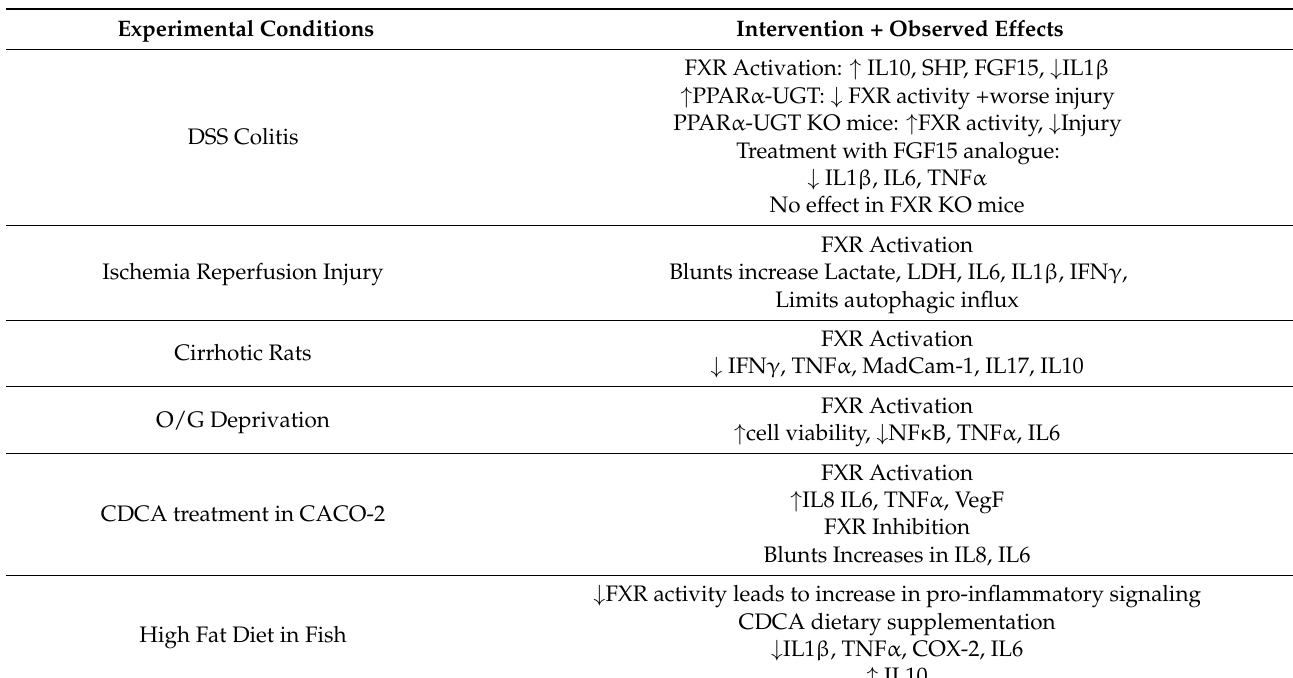
Table 1. Known FXR responses in experimental models of inflammation (SHP—small heterodimer protein; IL—interleukin; PPAR α -UGT—peroxisome proliferator-activated receptor (PPAR α )-UDP-glucuronosyltransferases (UGTs); Veg—vascular endothelial growth factor; FGF—fibroblast growth factor, IFN—interferon; madcam—mucosal addresin cell adhesion